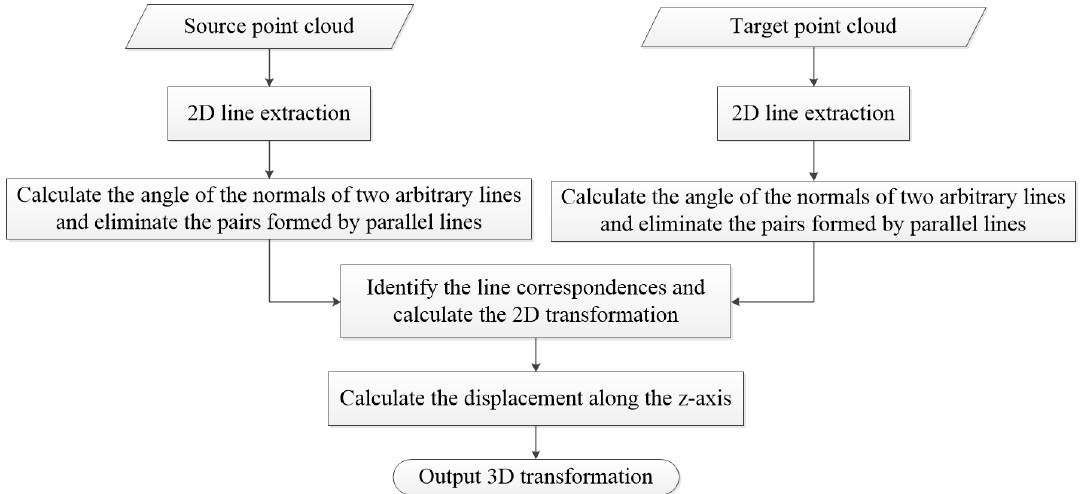
Figure 2. The outline of our registration method.